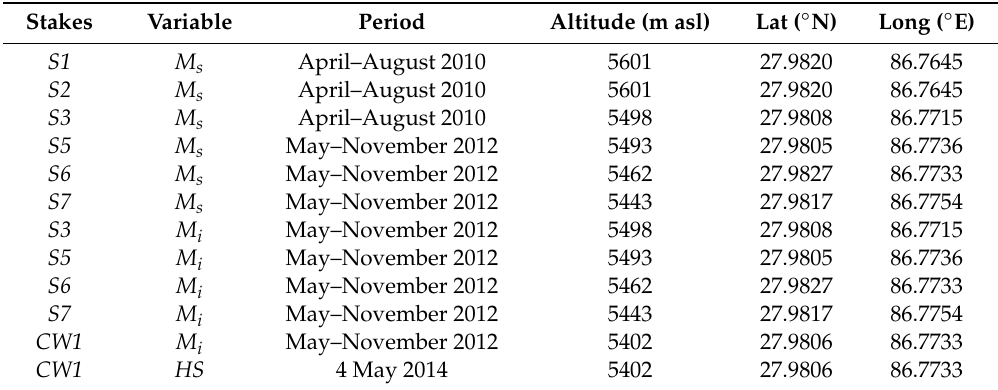
Table 2. Detail of snow and ice stakes on the West Khangri Nup glacier, 2010–2014. M i is ice melt, M s is snow melt, HS is snowpack